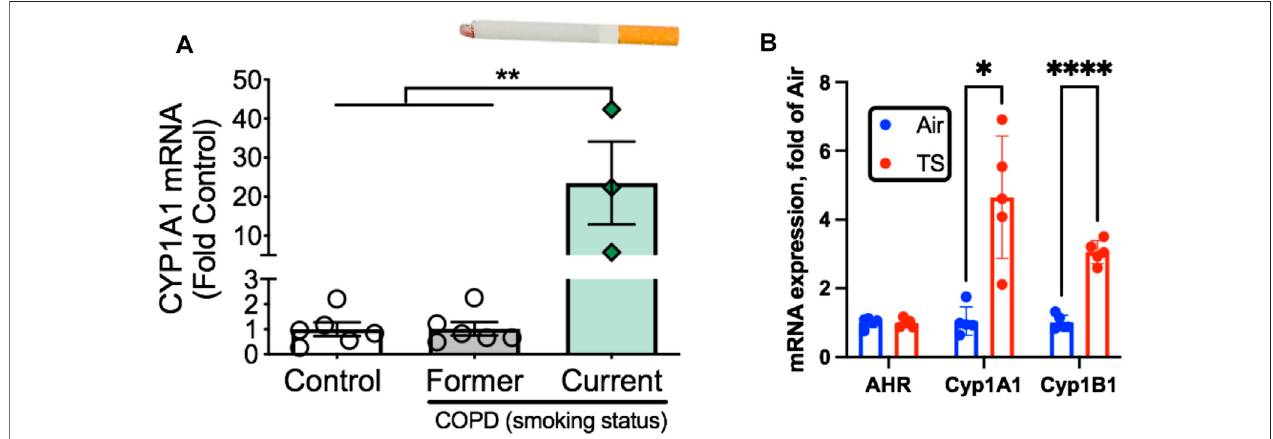
FIGURE 6| Tobacco smoke exposure activates AHR signaling in skeletal muscle. (A) AHR signaling (Cyp1A1 expression) is elevated exclusively in COPD patients who are current smokers but not those who were former smokers. (B) Acute tobacco smoke exposure (2 × 60 min exposures separated by 30 min) in mice leads to increases AHR signaling in skeletal muscle (Cyp1A1, Cyp1B1). Graphs are adapted from Thome et al., 2022.